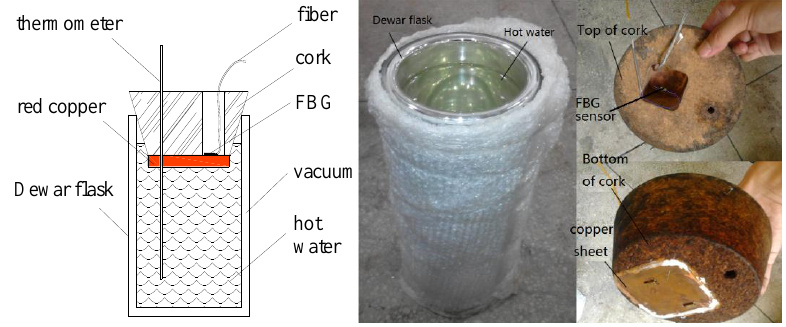
Figure 6. Principle schematic and experimental setup of a surface-typed temperature standard.